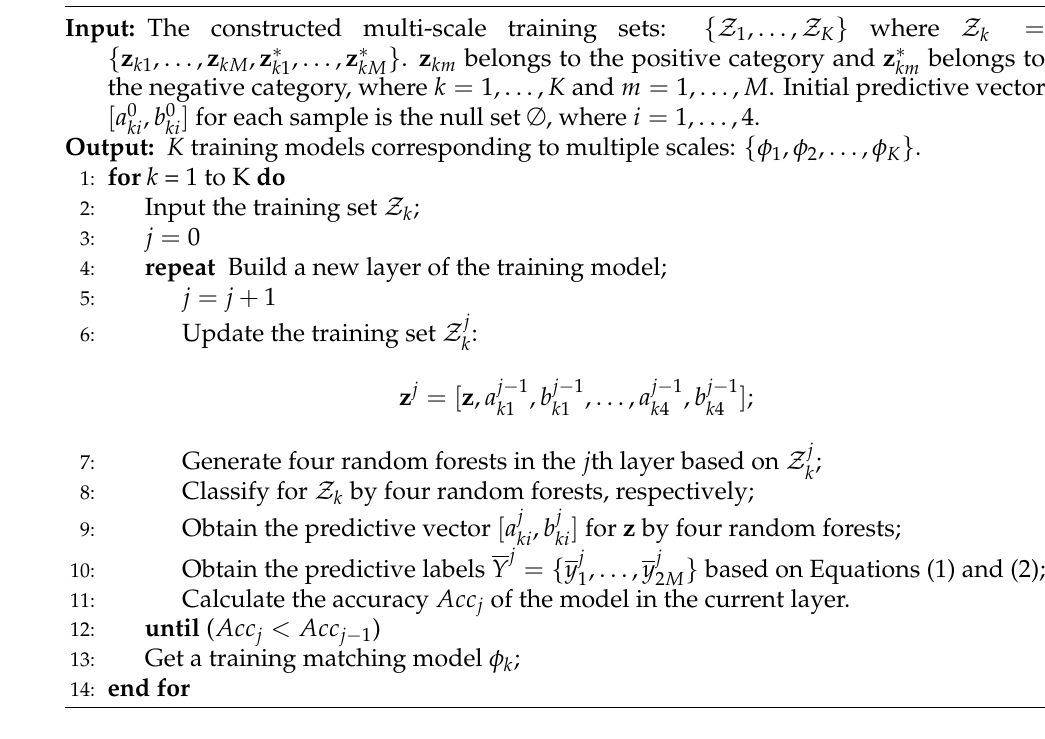
Algorithm 1 The Procedure of Traing Matching